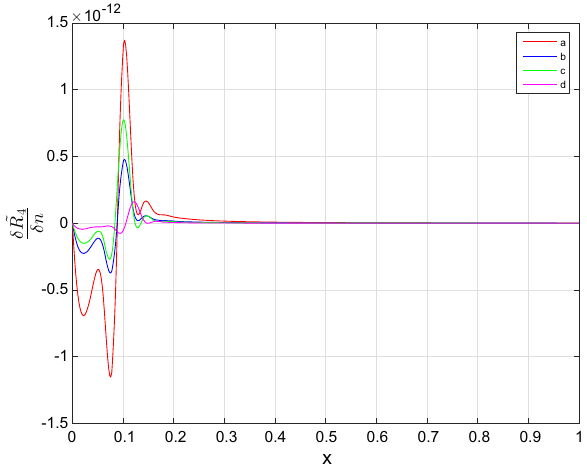
Fig. 8 Case 2: Perturbation through n , h , q . δ R 4 δ n = 1 , α = 2 × 10 − 10 , α 1 = 0 . 4 , h = 0 . 5, red curve q = 0 . 2 M (cid:7) , blue curve q = 0 . 4 M (cid:7) , green curve q = 0 . 6 M (cid:7) , magenta curve q = 0 . 64 M (cid:7)